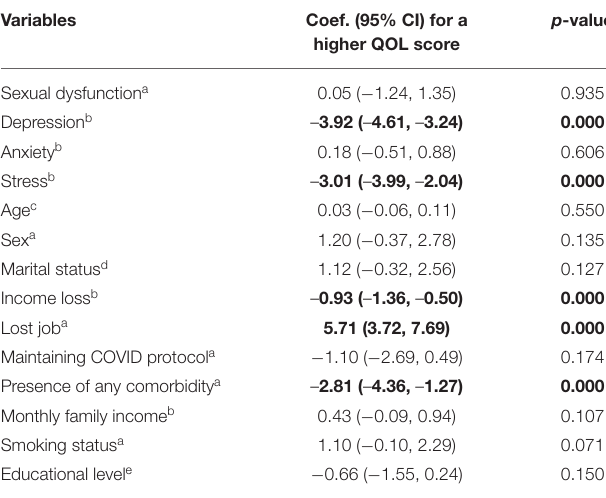
TABLE 4 | Relationship between socio-clinical factors and quality-of-life of the respondents as per generalized structural equations model analysis.